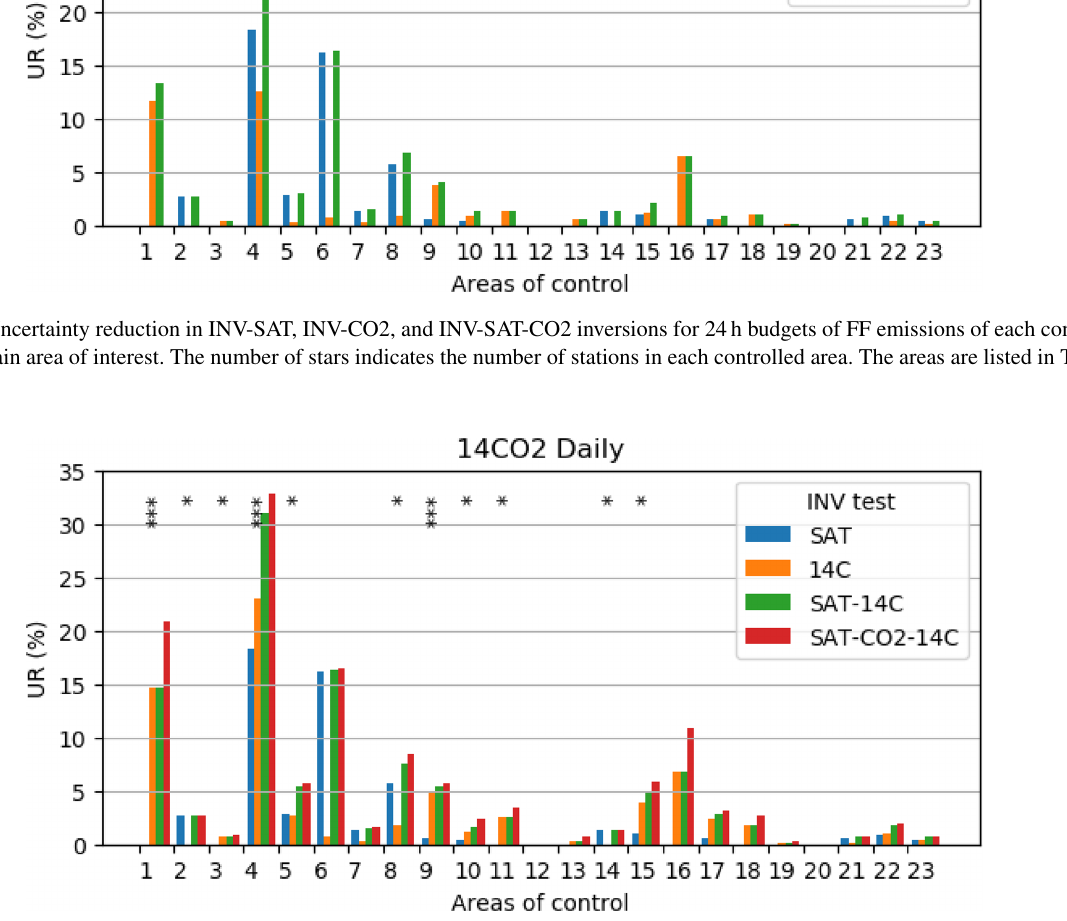
Figure A2. Uncertainty reduction in INV-SAT, INV-14C, INV-SAT-14C, and INV-SAT-CO2-14C inversions for 24h budgets of FF emissions of each controlled area in the main area of interest. The number of stars indicates the number of stations in each controlled area. The areas are listed in Table